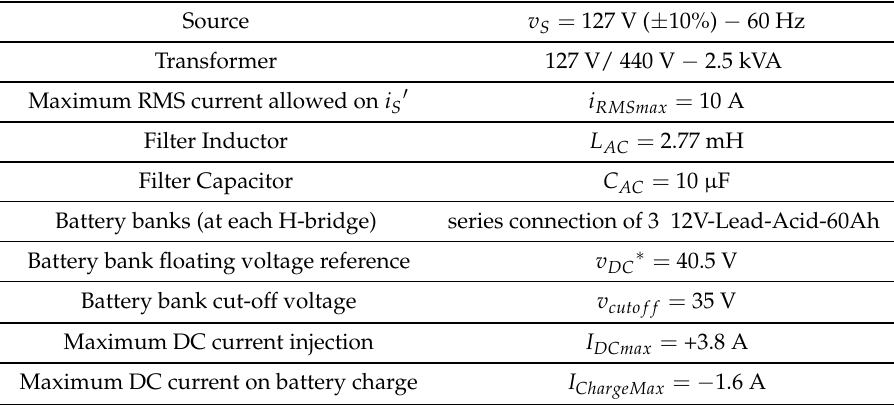
Table 3. Parameters of the power